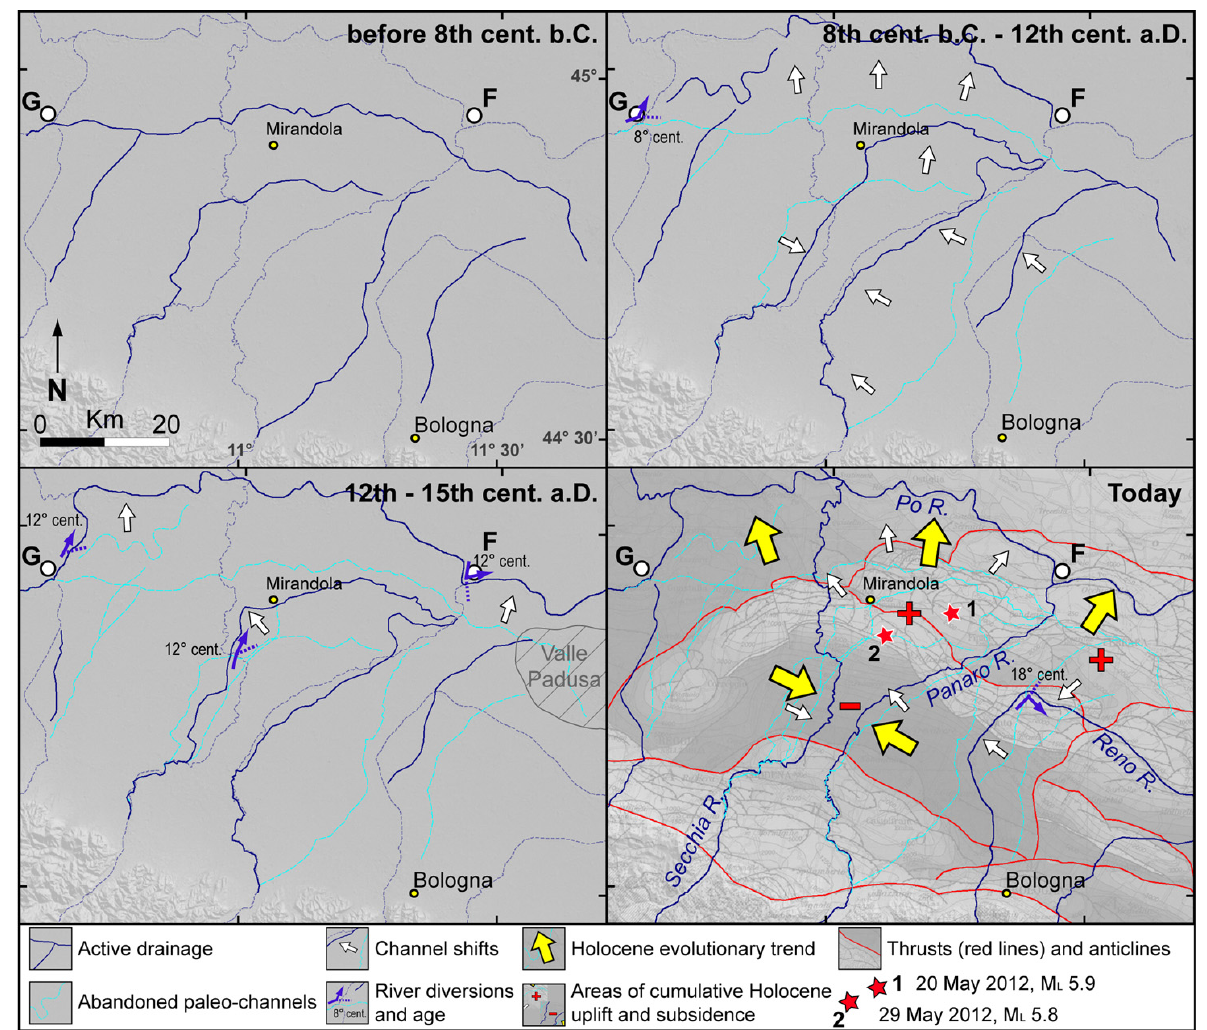
Figure 4. Drainage network evolution in the central part of the southern Po Plain north of Bologna, modified after Castaldini et al. [1979] and MURST [1997a]. The modern drainage pattern is reproduced in the background of all of the panels. The basemap of the lower-right panel is from Bigi et al. [1992]. The coseismic elevation changes detected by the DInSAR technique [see Bignami et al. 2012, this volume] fit the buried syncline-anticline pair well. Rivers are attracted towards areas of relative subsidence; e.g., synclines and thrust-top basins, and diverted away from the buried growing anticlines. Age of diversions from MURST [1997a]. F, Ficarolo; G,